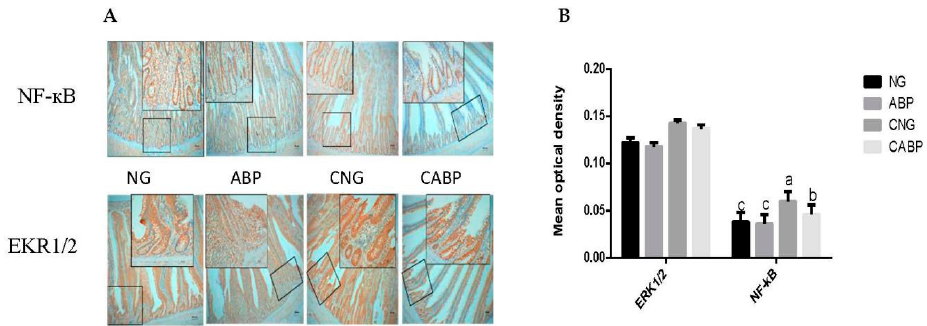
Figure 2. Response of NF- к B and EKR1/2 in the jejunum. ( A ) NF- к B and EKR1/2 immunostaining of mucosa (original magnification 100× and 400×). Only brown-colored staining was considered positive. ( B ) Density quantification of brown-colored staining. Significant interaction between E. coli challenge and ABPS was observed for NF- κ B activation, but not for ERK1/2 activation ( p = 0.055). Values are means ± SE, n = 6. Different superscripted lowercase letters within each group mean the values differ significantly ( p < 0.05). NG: basal diet; ABP: supplemented with 500 mg ABPS additive per kg of diet; CNG: basal diet group with E. coli challenge; CABP: ABP group with E. coli